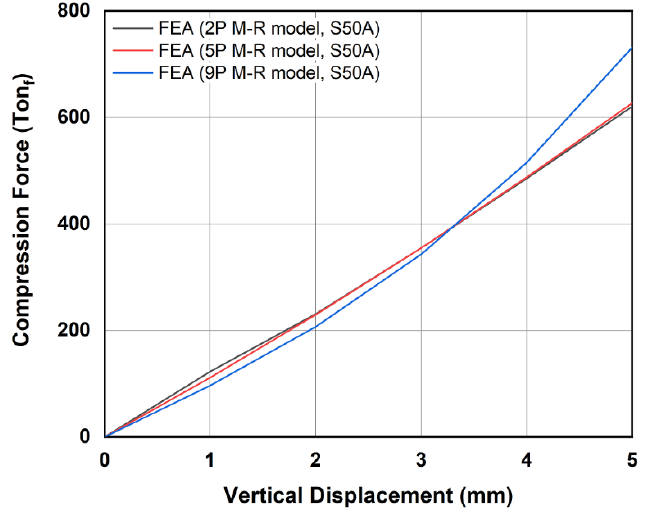
Figure 11. Compression force-displacement graph with respect to the three M-R models through the numerical simulation. Table 8. Shear force and displacement with respect to the number of elements across an elastomer layer (NE) through the numerical simulation (FEA). The thickness of elastomer in this specimen (T q ) is 130